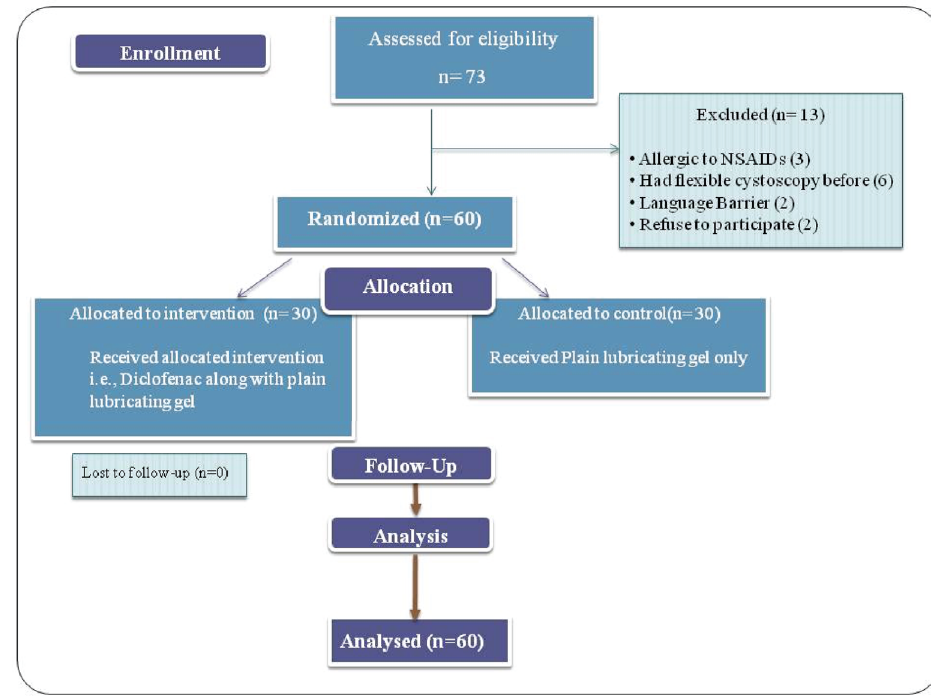
Figure 1. CONSORT statement describing the details eligibility, allocation, follow up and analysis of the